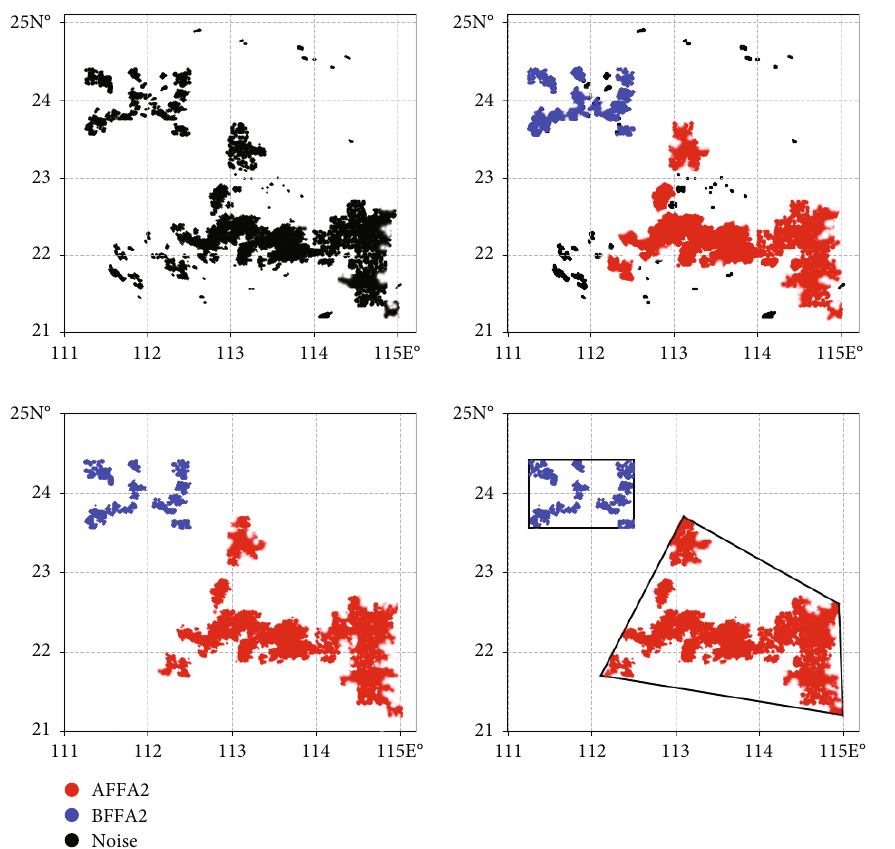
Figure 11: The fi nalized dynamic fl ight-restricted